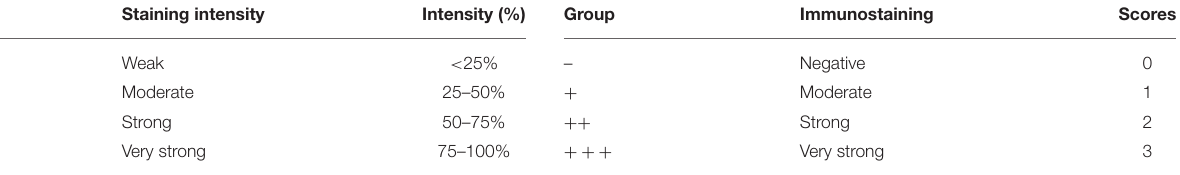
TABLE 1 | Classification: immunostaining of cytoplasmic cells and nucleus of tumor cells. Group